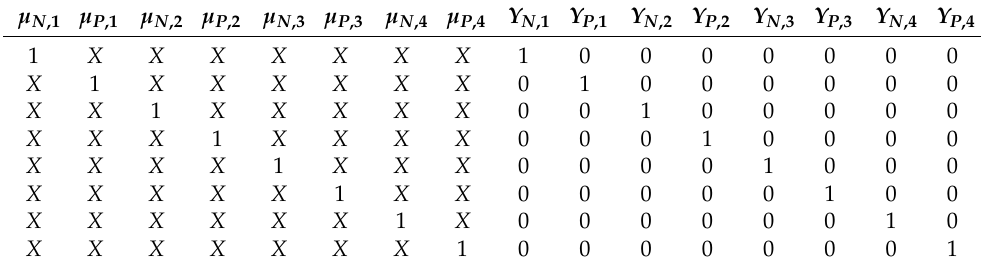
Table 20. Rules associated with the estructure of Figure 24.